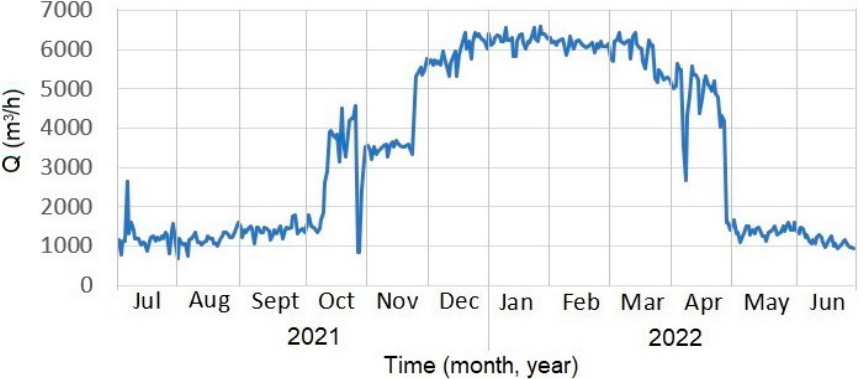
Figure 16. Water discharge variation in the transmission network.